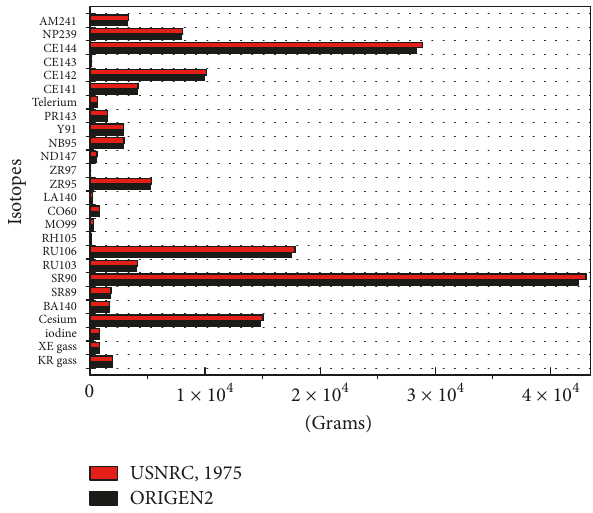
Figure 7: Selected isotope mass inventory for one complete fuel cycle of 1000MWe conventional